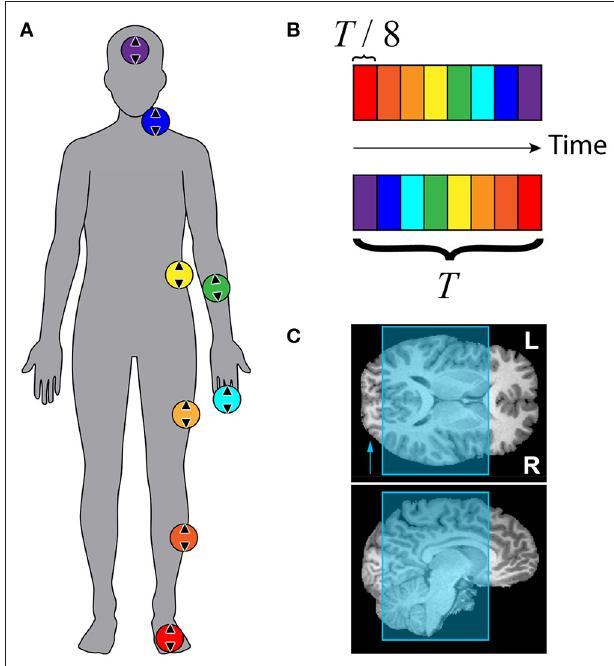
FIGURE 2 | Stimulation paradigm and scan coverage for somatosensory mapping with fMRI. (A) Colored circles represent approximate stimulator locations: glabella, neck near collarbone, anterior forearm, middle fingertip, trunk beneath ribcage, thigh, shin, and volar side of foot. Arrows within circles show approximate orientation of linear actuators. (B) Colored boxes depict timing of tactile stimuli. Top: forward sequence. Bottom: reverse sequence. Total stimulation period T was 72 s (40 s for subject F). Each stimulator was active for T / 8 = 9 s (5 s for subject F) before switching to the next. Each run consisted of 5 stimulation periods (9 for subject F). (C) EPI slice coverage overlaid on T1-weighted MR images. Slices were stacked along the anterior-posterior axis. Phase encoding direction was right-left, indicated by the arrow in the axial